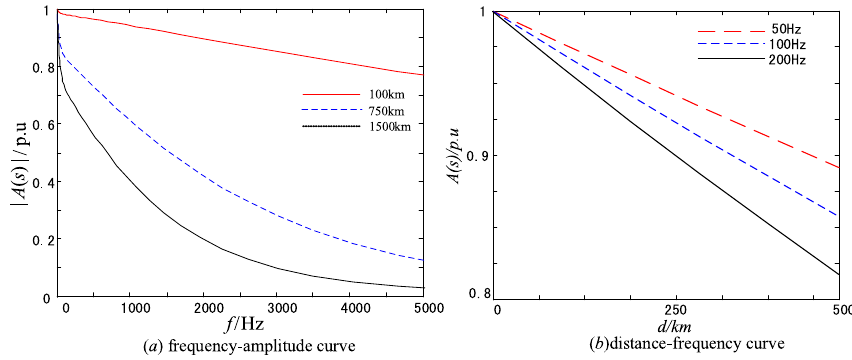
Fig. 6 Attenuation curve of signal